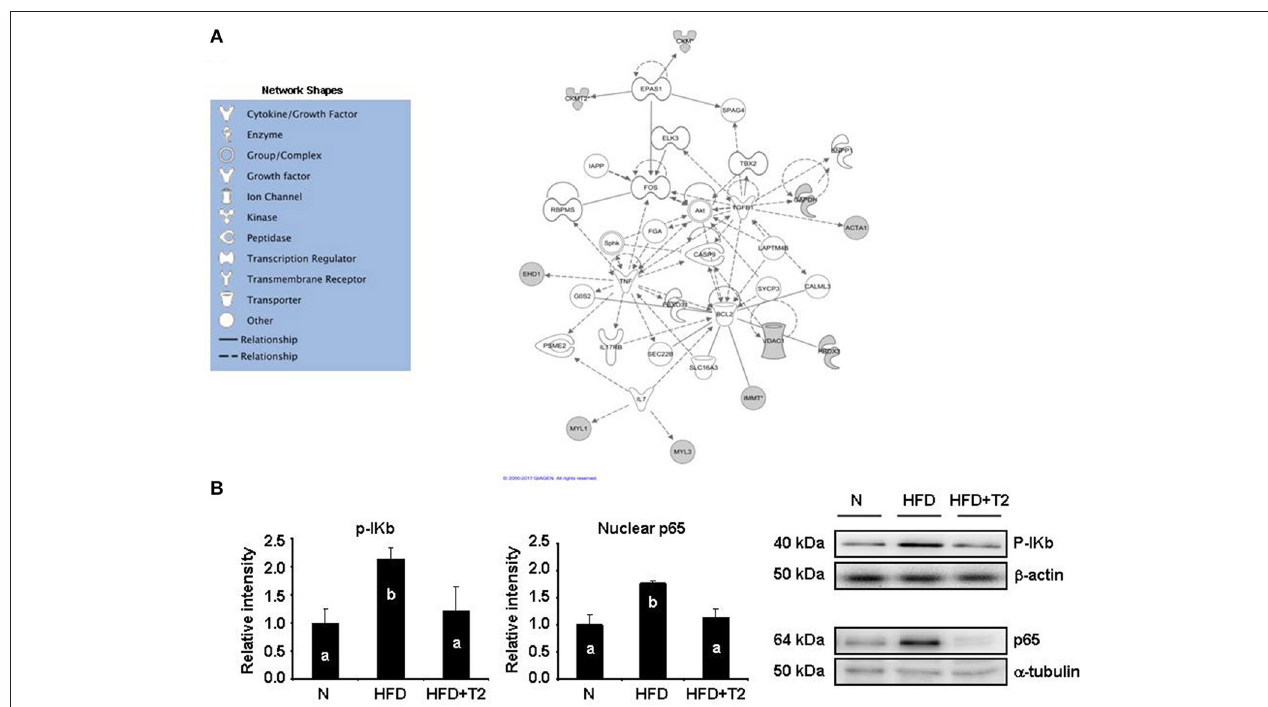
FIGURE 3 | In silico protein network analysis. (A) Network representation of the molecular relationships between identified, differentially represented gastrocnemius muscle proteins (Ingenuity Systems Ltd.). Gene products are represented as nodes, and the biological relationship between two nodes is represented as an edge (line). Indirect interactions without physical contact appear as broken lines, whereas direct interactions requiring direct physical contact between nodes appear as solid lines. All edges shown are supported by at least 1 reference from the literature, from a textbook, or from canonical information stored in the Ingenuity Pathways Knowledge Base. Human, mouse, and rat orthologs of a gene are stored as separate objects in IPKB, but are represented as a single node in the network. For clarity, network shapes are shown. (B) Western blot analysis of the expression levels of p-Ikb and p65 subunit of NF-kB in gastrocnemius muscle of N, HFD, and HFD + T2 rats. p65 expression was measured in nuclear extracts. Gastrocnemius muscle proteins were normalized based on β -actin. Nuclear proteins were normalized based on α -tubulin. Data were normalized to the value obtained for N animals, set as 1, and presented separately for each treatment (means ± SD; n = 4/6). Bars labeled with dissimilar letters are significantly different ( P <